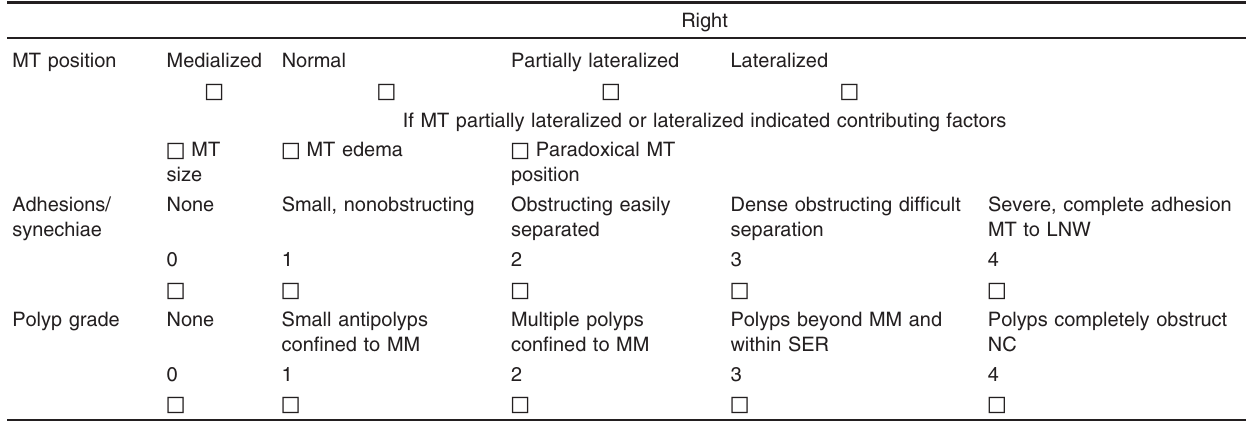
Table 1 Endoscopic grading form